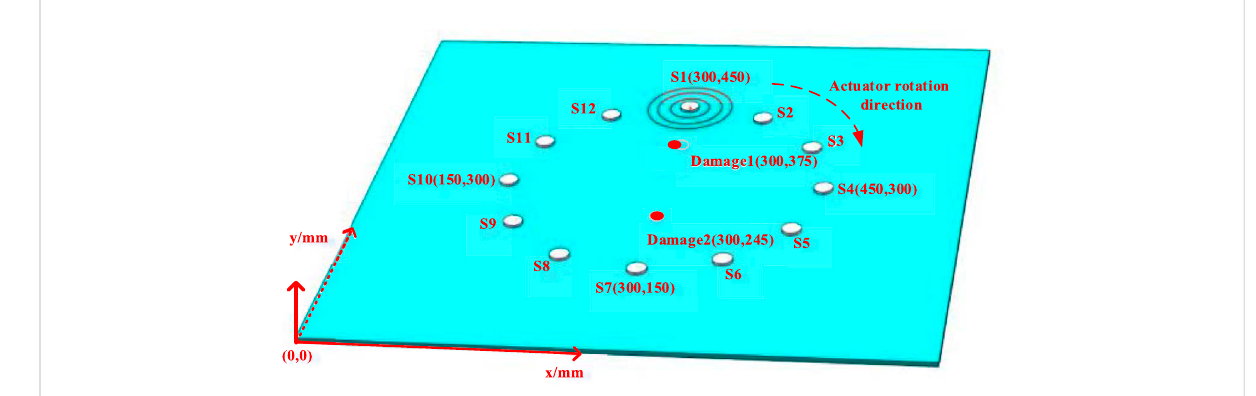
FIGURE 7 Schematic diagram of sensor and multi-damage location.